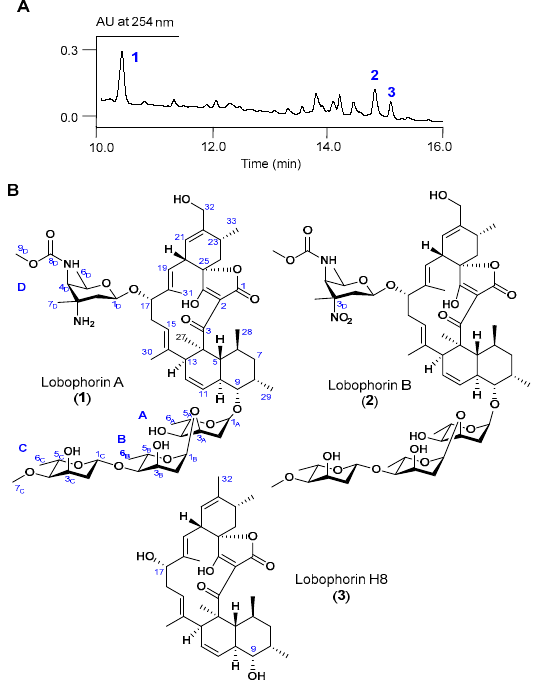
Figure 2. HPLC of the crude extract and chemical structure of the isolated LOBs 1 – 3 . ( A ) HPLC analysis of S . sp. CB09030 culture extract. ( B ) The structures of isolated 1 (LOB A), 2 (LOB B), and 3 (LOB H8) from S . sp. CB09030.